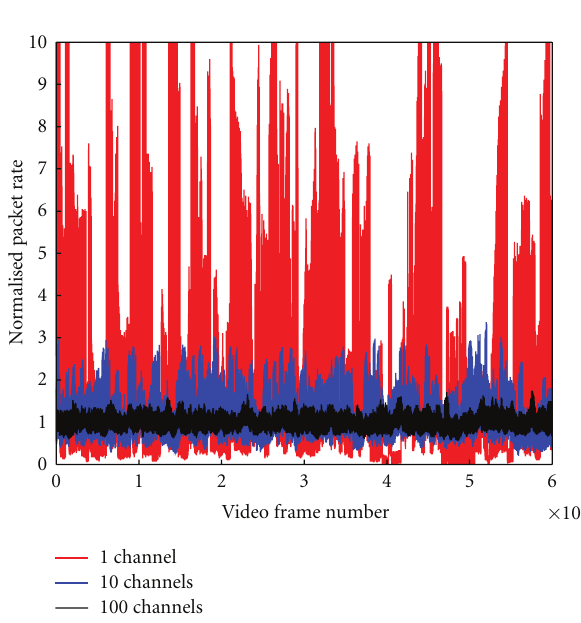
Figure 3: Burstiness of aggregated tra ffi